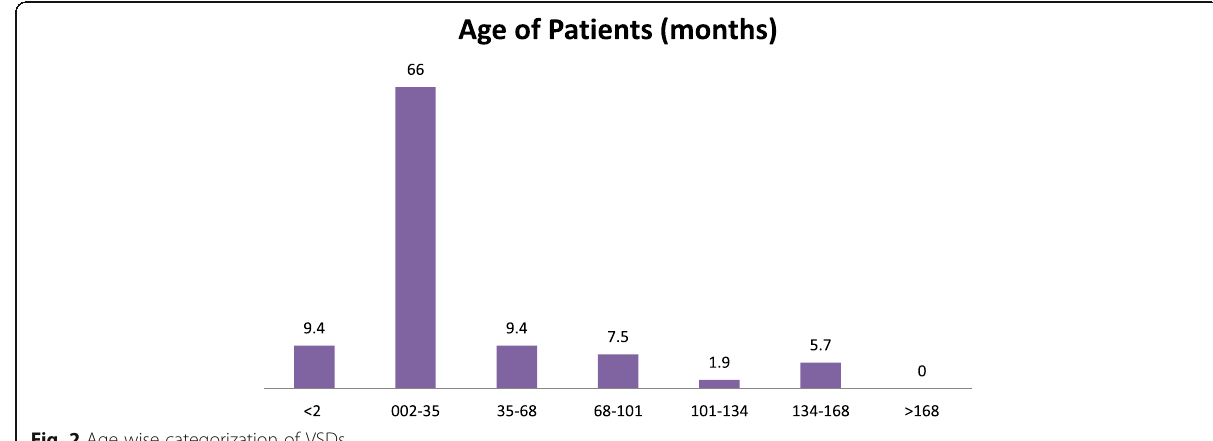
Fig. 2 Age wise categorization of